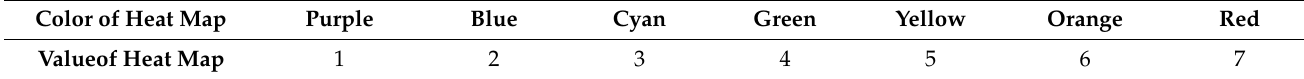
Table 1. The scores corresponding to the different colors of the heat map. Color of Heat Map